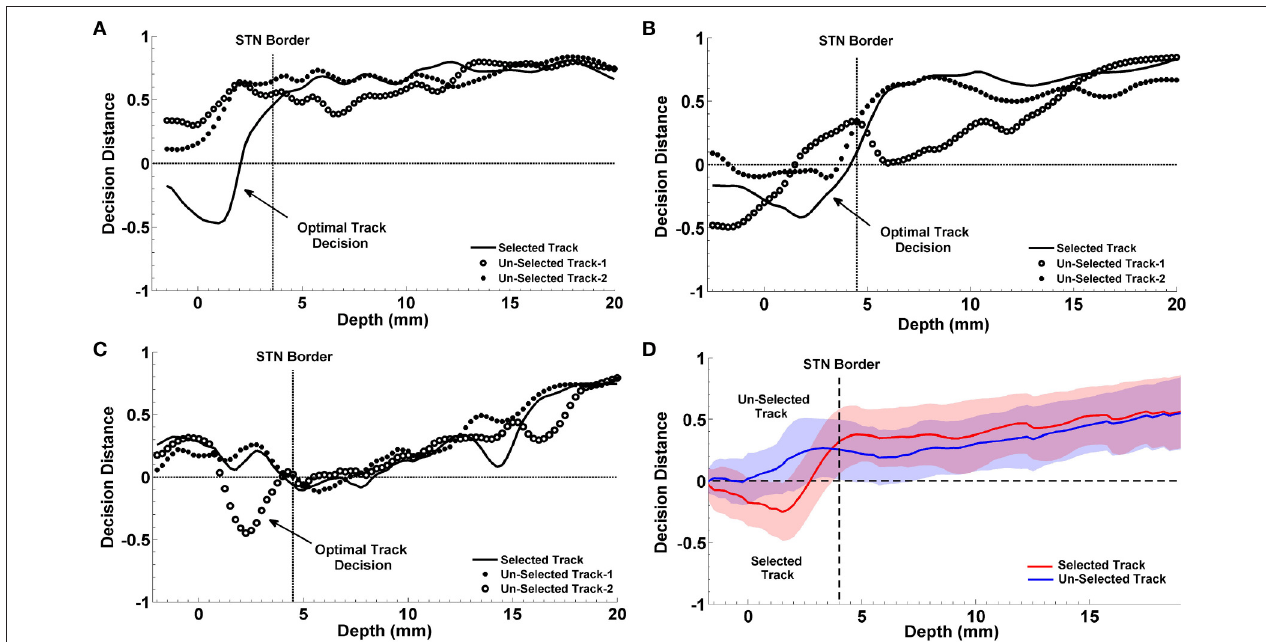
FIGURE 10 | Progression of classification in optimal track prediction. The progression of classification over depths for three representative subjects are shown in (A–C) . The black dashed lines show the STN border provided by the neurosurgeon based on the SUA interpretation. The decision distances with the highest confidence and the longest span below the STN border indicate the optimal track. Panel (A) shows that decision distance is reaching the highest confidence level only in selected track which is determined as the optimal track by the algorithm. Panel (B) shows that all tracks pass the zero line however, only the selected track points the longest span of decisions. So, the selected track is determined as the optimal track by the classifier. Panel (C) demonstrates a misclassified subject. Since only the un-selected track-2 is passing zero line and reaching the highest confidence level, it is determined as the optimal track by the algorithm. Panel (D) shows the average optimal track decisions with the standard deviation coming from all test subjects. It shows a clear separation in decision distances between selected (red) and un-selected tracks (blue) indicating a high percentage of correct prediction among the subjects.